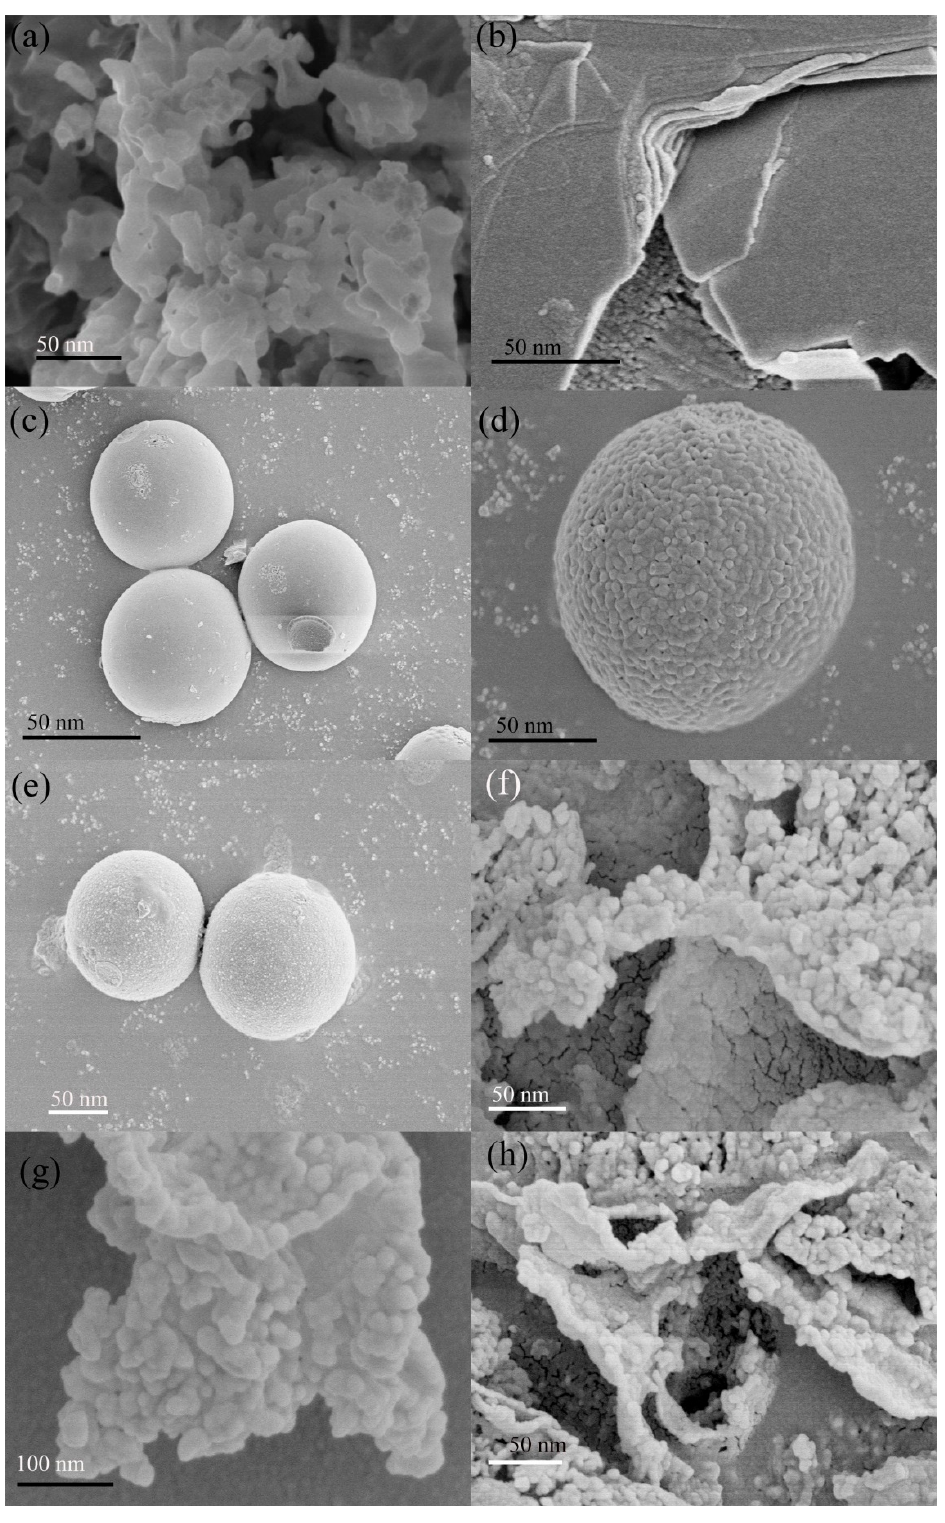
Figure 4. The FESEM microstructure of ( a ) g-C 3 N 4 nanosheets, ( b ) AgI, ( c ) LaFeO 3 , ( d ) GdFeO 3 and ( e ) YFeO 3 nanospheres, ( f ) AgI / LaFeO 3 / g-C 3 N 4 , ( g ) AgI / GdFeO 3 / g-C 3 N 4 , and ( h ) AgI / YFeO 3 / g-C 3 N 4